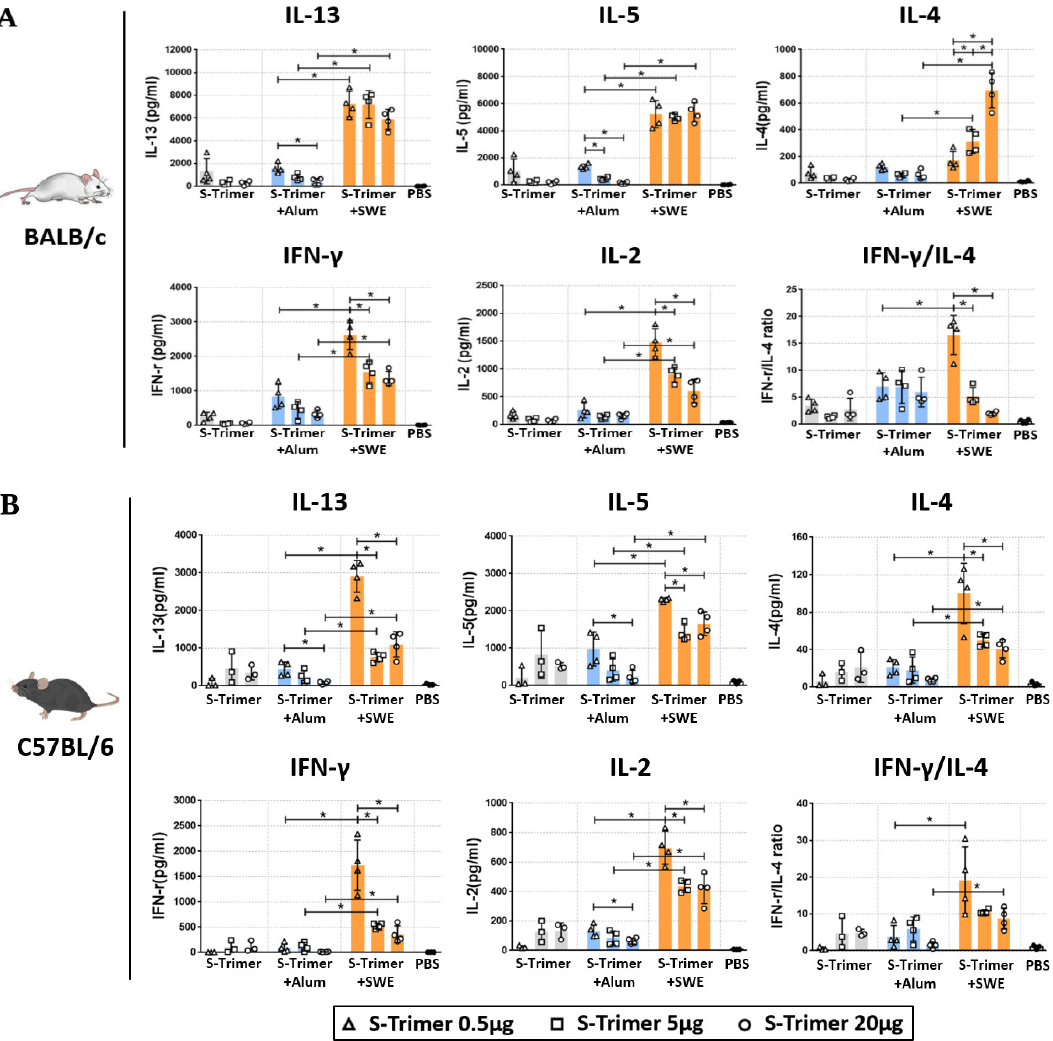
Figure 6. Cytokine production by spike-stimulated splenocytes from vaccinated mice BALB/c ( A ) and C57BL/6 ( B ) mice ( n = 3–4/group) were administered PBS as a control or 0.5 μg or 5 μg or 20 μg of S-Trimer protein with or without adjuvant (Alum or SWE) via intramuscular (IM) injection twice on Day 0 and 28. Splenocytes were collected at two weeks from the second vaccination and incu- bated with SARS-CoV-2 S ectodomain to restimulate cytokine secretion. The secretion level of Th2 cytokine (IL-13, IL-5, and IL-4), and Th1 cytokine (IFN-γand IL-2) was evaluated by indirect ELISA. The Th1/Th2 ratio was calculated from each producing amount of IFN-γ and IL-4. Each symbol represents the cytokine value from an individual mouse; each group of cytokines’ value was pre- sented as the mean ± SD. Statistical analysis of all comparisons was made by two-tailed Mann– Whitney tests. * p < 0.05 was considered significant. 2.5. Humoral Immune Responses and Protective Efficacy in Vaccinated Syrian Hamsters We next evaluated the protective efficacy of the S-Trimer vaccines to prevent viral infections and associated diseases since SARS-CoV-2 showed limited binding to mouse ACE2, which has limited the use of inbred mice for research. Hamster ACE2 binds tightly to the SARS-CoV-2 S protein and mediates its entry [29]; therefore, hamsters are a compe- tent infection model for studying the pathogenesis of SARS-CoV-2 infections [30]. In this study, Syrian hamsters were intramuscularly immunized twice at a 4-week interval and intranasally infected with SARS-CoV-2 on Day 45 (Figure 7A). Serum samples were col- lected on Day 42 and subjected to different methods to assess antibody responses. The levels of ELISA (Figure 7B), ACE2 blocking (Figure 7C), and live-virus neutralization titers (Figure 7D) measured in sera from the S-Trimer/SWE groups were significantly higher than those from the nonadjuvanted S-Trimer groups at each corresponding antigen dose level or the S-Trimer/Alum groups at the lowest antigen dose (0.5 μg).